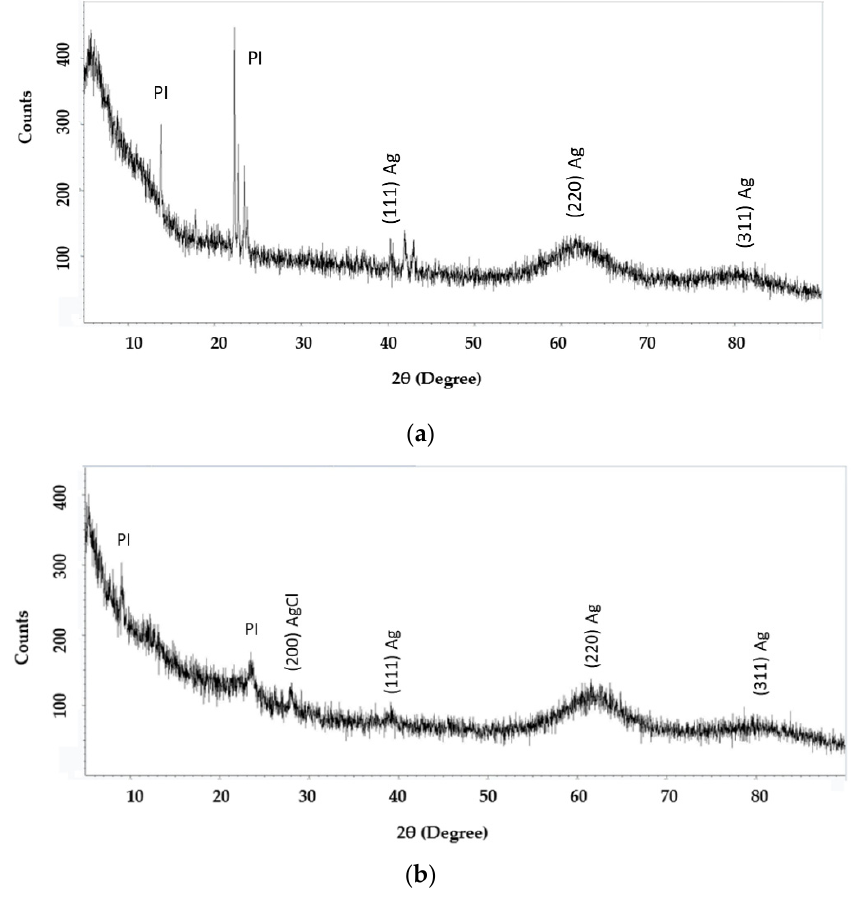
Figure 8. X-ray diffraction (XRD) analysis of the two samples. From up to down: ( a ) TCA-AgNP-PI; Figure 8. X-ray di ff raction (XRD) analysis of the two samples. From up to down: ( a ) TCA-AgNP-PI; ( b ) Cinn-AgNP-PI. ( b )